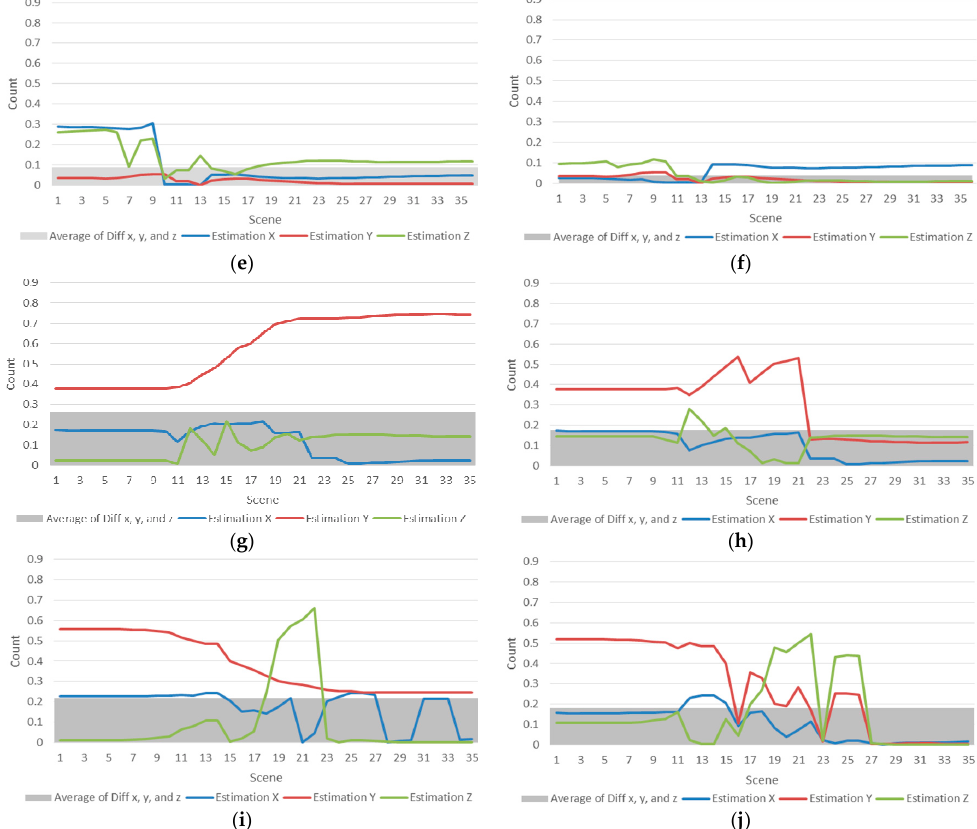
Figure 9. Differences in orientation-based estimation between the traditional method [17] and the proposed method, and the average of cumulative errors in the x, y, and z orientations. ( a , c , e , g ) and ( i ) compare the differences in the estimated motion of the x, y, and z orientations using the previous research method. ( b , d , f , h , j ) showing the differences in the estimation results of these orientations when they are weighted by the proposed algorithm.